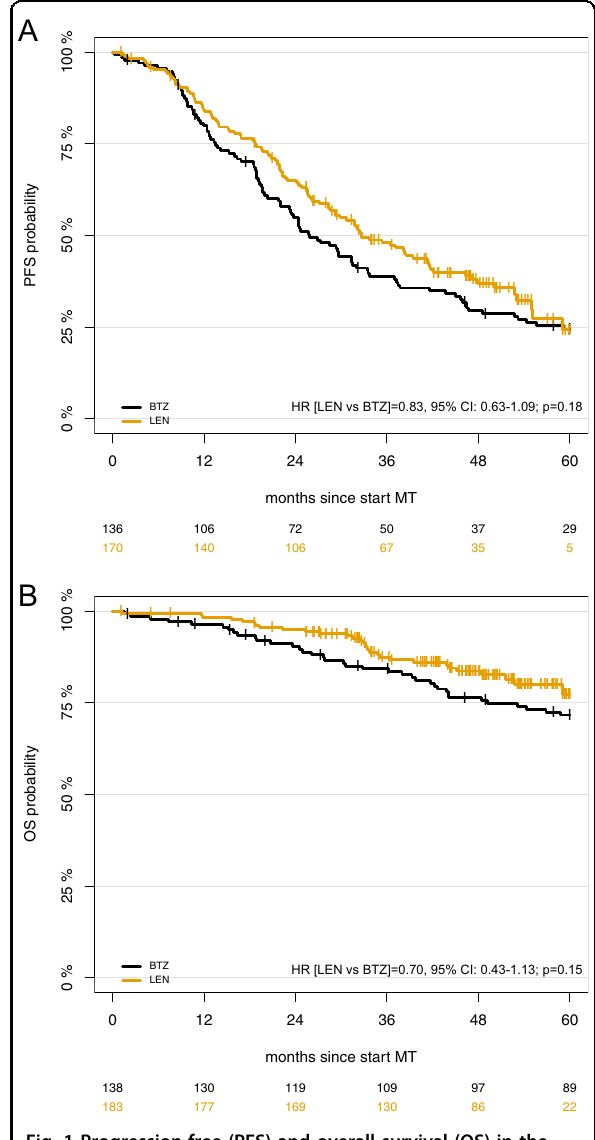
Fig. 1 Progression-free (PFS) and overall survival (OS) in the overall cohorts. Kaplan – Meier curves are shown for ( a ) PFS and ( b ) OS. LEN lenalidomide, BTZ